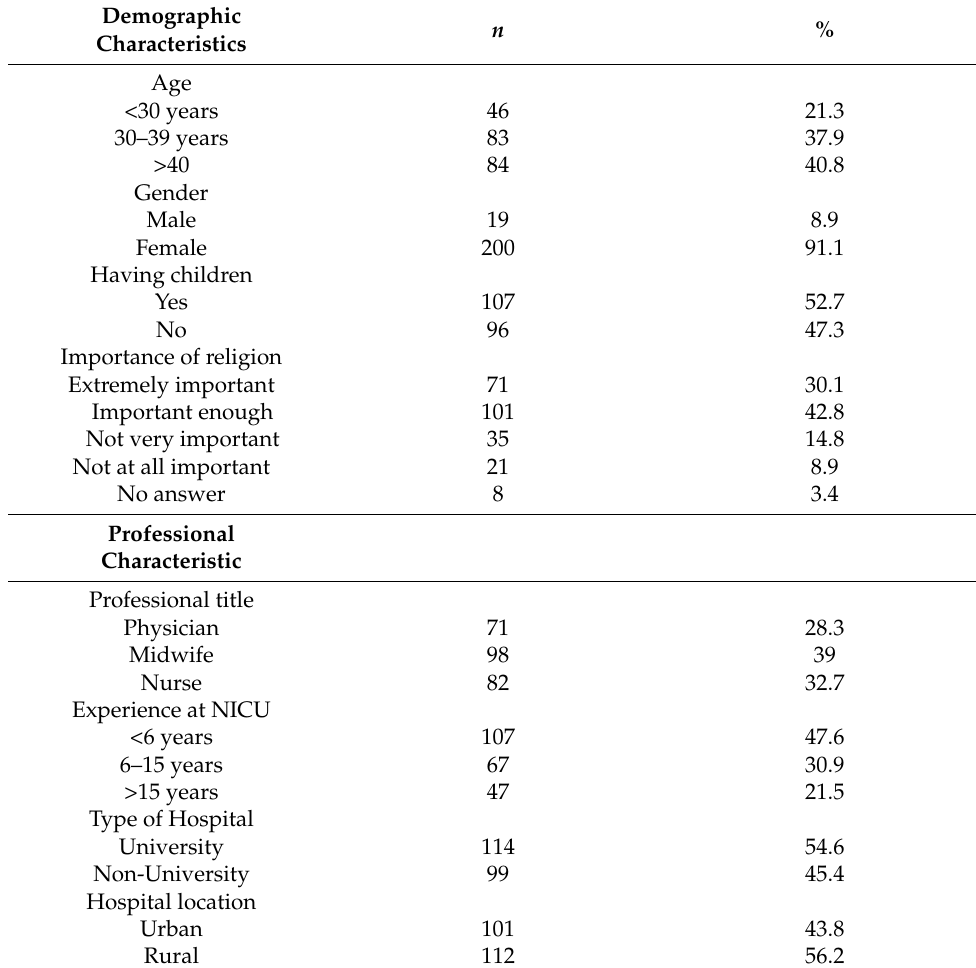
Table 2. Demographic and professional characteristics of